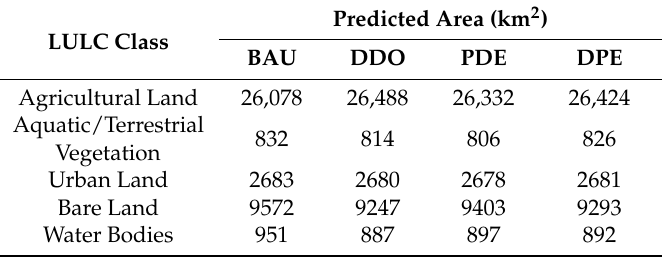
Figure 8. Simulated LULC scenarios: ( A ) BAU, ( B ) DDO, ( C ) PDE, ( D ) DPE. Table 4. The simulated future scenarios LULC total areas over the Nile Delta.